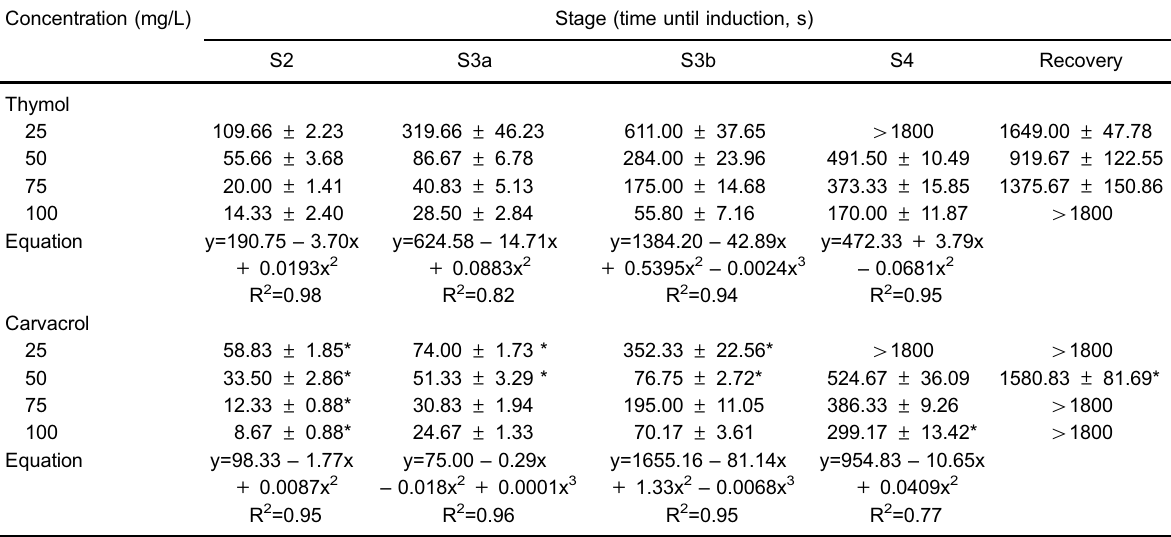
Table 1. Time (in s) required for induction and recovery from anesthesia with thymol and carvacrol in silver cat fi sh ( Rhamdia quelen) juveniles.